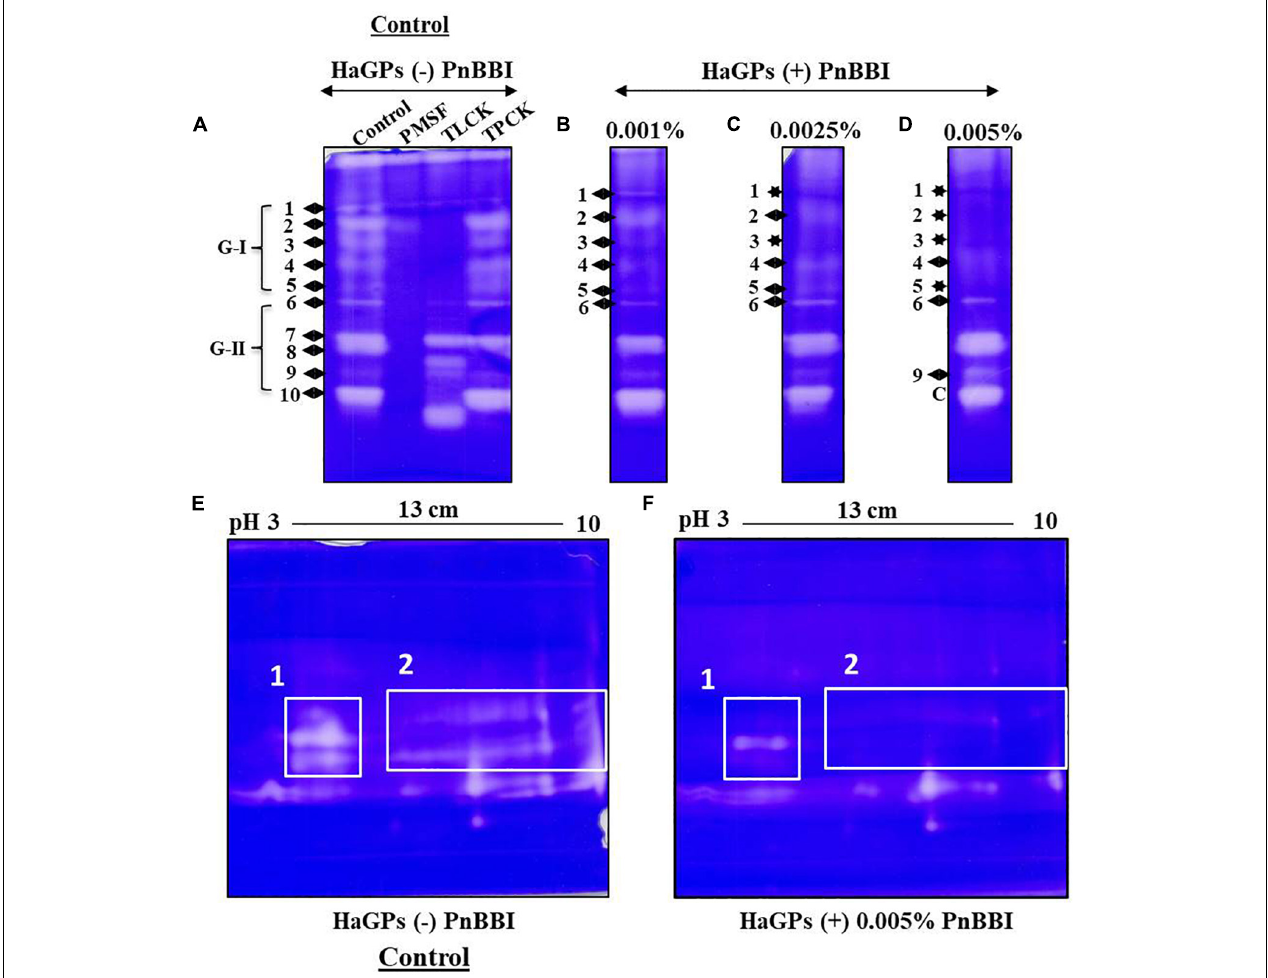
FIGURE 8 | Comparative Zymography of HaGPs from larvae fed on PnBBI. Casein Native-PAGE zymogram of HaGPs extracted from larvae (day9) fed on diet with (A) No PnBBI (Lane1: HaGPs, lane2: HaGPs + PMSF, lane3: HaGPs + TLCK and lane4: HaGPs + TPCK); (B) 0.001% PnBBI; (C) 0.0025% PnBBI and (D) 0.005% PnBBI. Differential 2-DE zymography of HaGPs from larvae fed on (E) control diet and (F) 0.005% PnBBI supplemented diet. An equal amount of protein (8 µ g) from both samples was subjected to rehydration of IPG strip under native condition followed by IEF, second dimensional SDS-PAGE (10%) and zymography as described in materials and methods (Section “Extraction of H. armigera Midgut Proteases (HaGPs) and Zymography”). The respective clear zones against the dark blue background are the result of casein digestion due to the presence of proteases. The area highlighted with boxes on 2-DE zymograms represents the disappearance of several proteases upon PnBBI ingestion as indicated against stars. The gel pictures are the selective representatives of two biological replicates (data provided as Supplementary Data Sheet 3